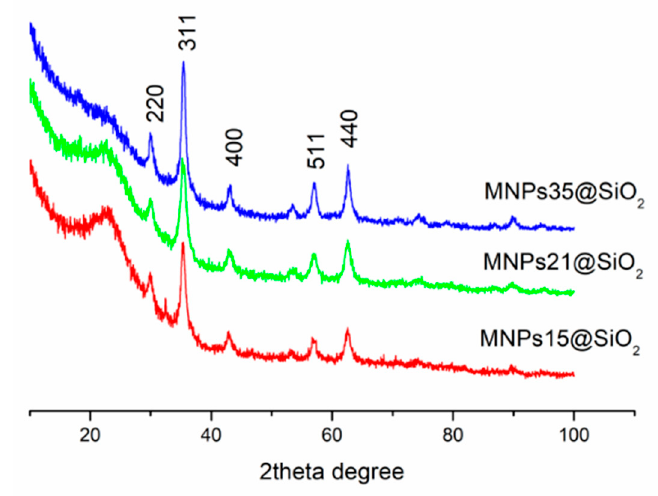
Figure 1. X-ray diffraction (XRD) patterns of the magnetic nanocomposites obtained. Table 2. Average crystallite size.